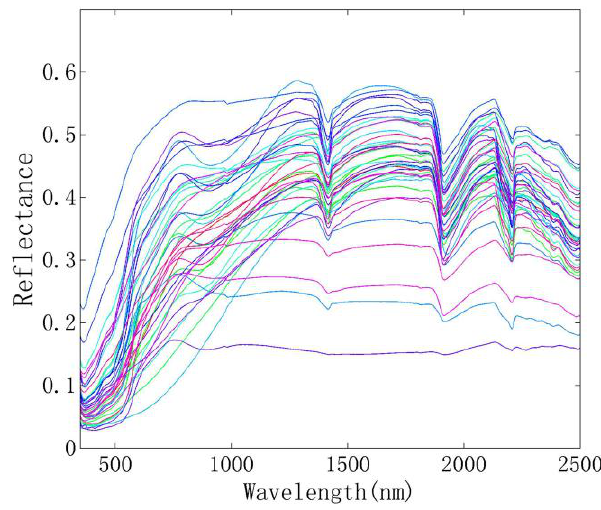
Figure 2. Reflectance of the 40 soils used to represent the possible range of spectral shapes.